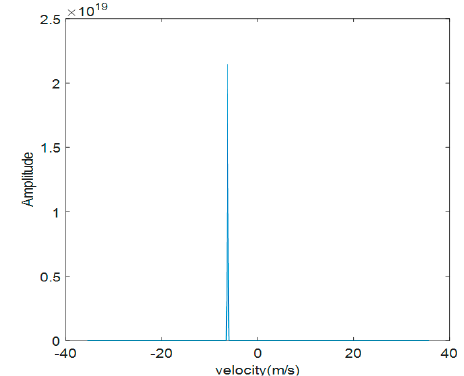
Figure 12. The measured raw DMS.